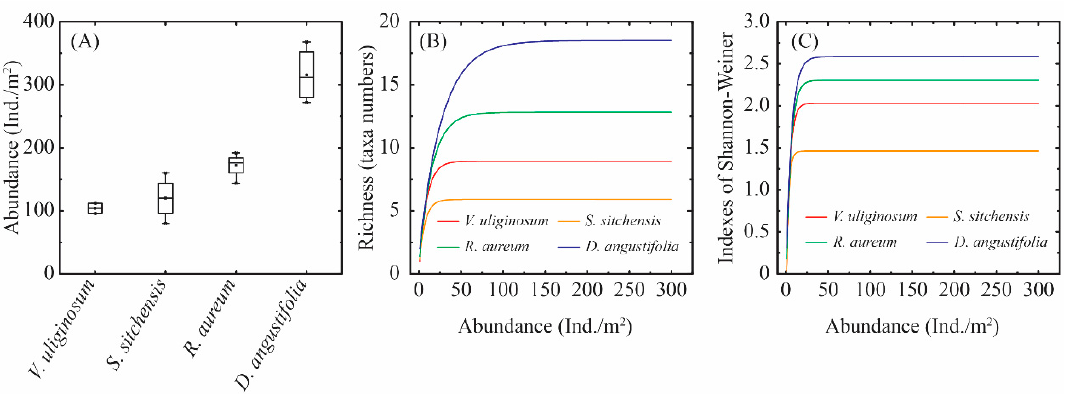
Figure 2. Diversity characteristics of soil macro-arthropods in di ff erent habitats. ( A – C ) Box-Whisker plots illustrating the medians (line in the box), 25th and 75th percentiles (box), 10th and 90th percentiles (outer lines), and mean values (dots) of abundance ( A ) of soil macro-arthropods in the di ff erent habitats. ( B , C ) Rarefaction curves of soil macro-arthropods richness and Shannon-Wiener index assemblage in the various habitats.